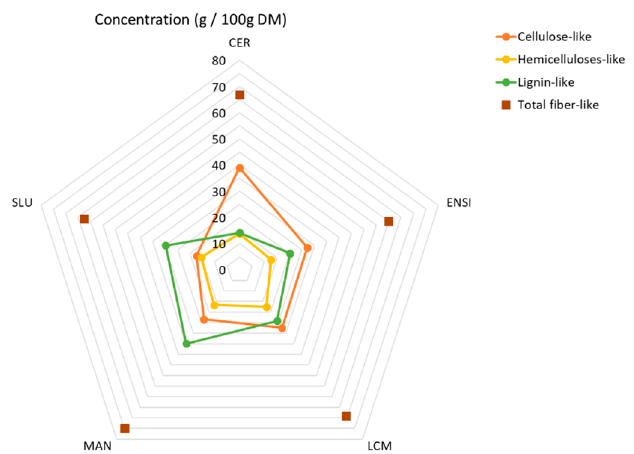
Figure 2. Means of the different family composition of fibers. Families: cereal and residue (CER), energy crop and silage (ENSI), lignocellulosic matter (LCM), manure (MAN), and slurry (SLU).